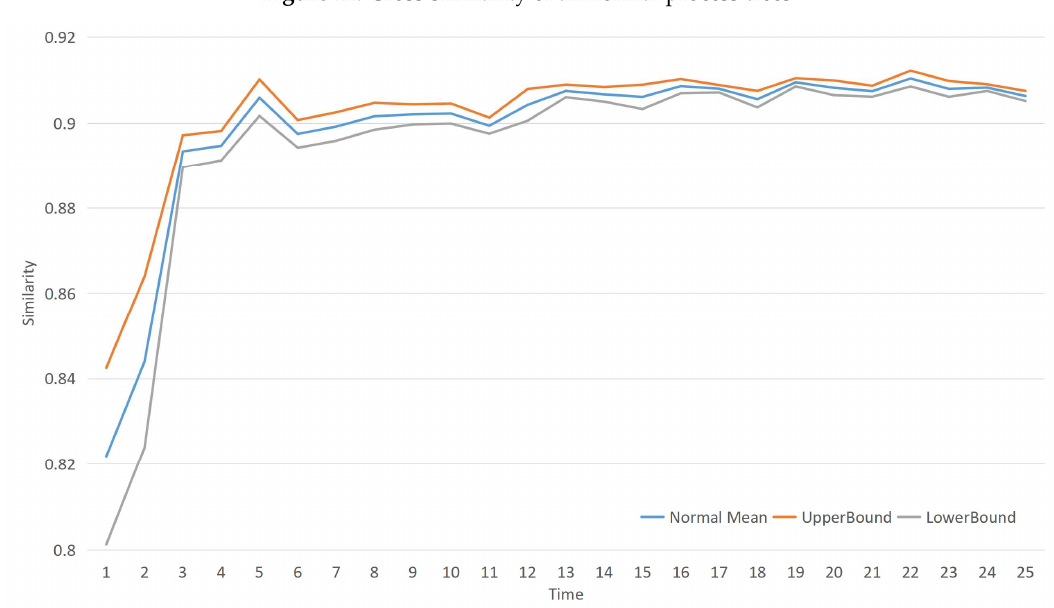
Figure 13. Mean of similarity of all normal process trees with lower bound and upper bound at a 95% confidence